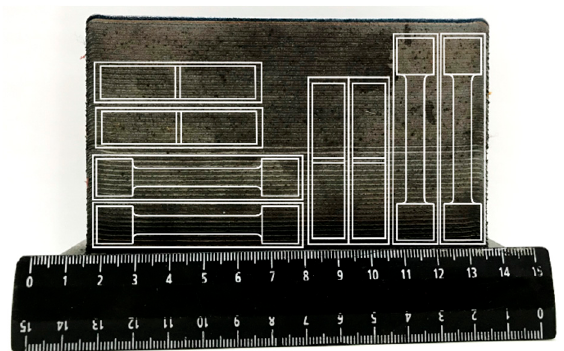
Figure 2. The scheme of cutting samples for mechanical testing.